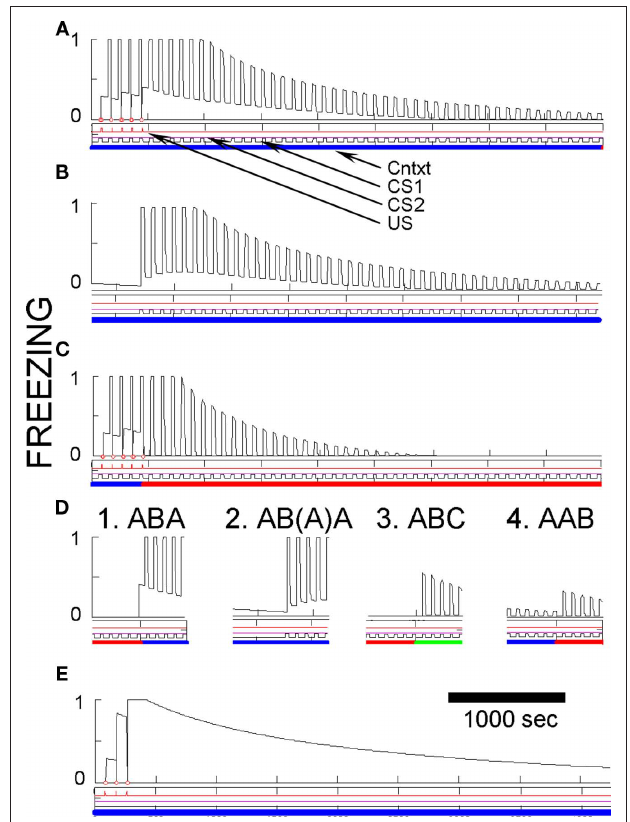
FigurE 7 | Basic fear conditioning, extinction, and renewal in FrAT. Unless otherwise specified, simulation of extensive exposure to all three contexts preceded all simulations shown. (A) Conditioning and extinction of CS1 in context A. Event lines are labeled and have the same meaning